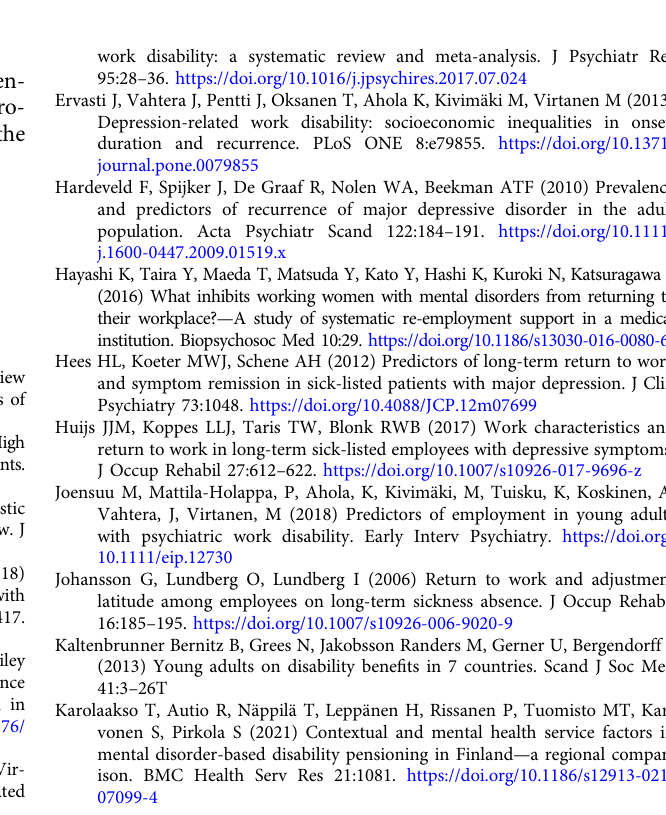
Fig. 3 Adjusted odds ratios of associations between personal, socio-economic, health and health care-related factors between people with partial RTW (red) and RTW (blue) after temporary disability pension, shown for men and women separately. This fi gure is covered by the CC BY-NC-ND